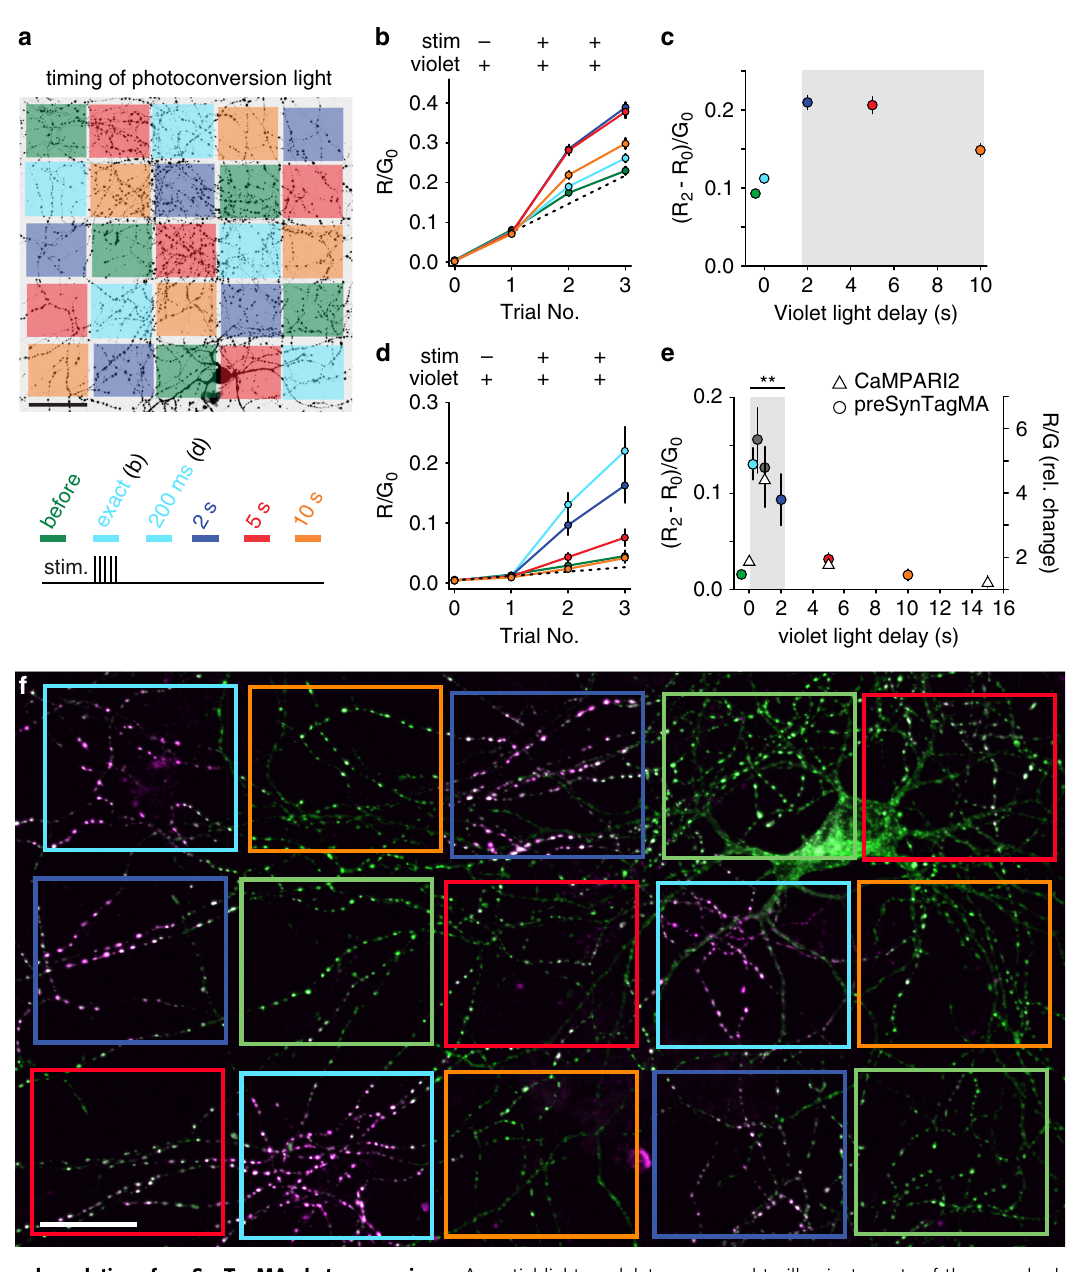
Fig. 2 Temporal resolution of preSynTagMA photoconversion. a A spatial light modulator was used to illuminate parts of the axonal arbor (405 nm, 50 mW cm − 2 , 100 ms) at different times relative to a brief tetanic stimulation (5 APs). After each trial, new images were acquired. ‘ Exact ’ & ‘ 200 ms ’ timing share the same color code (cyan) as we used ‘ exact ’ timing in sypCaMPARI experiments and a 200 ms delay in preSynTagMA experiments. b Ratio of red to green fl uorescence (R/G 0 ) from sypCaMPARI boutons illuminated at different times relative to the electrical stimulation. Trial 1 shows the effect of illumination without stimulation. Line color code as in a , n = 6 neurons. c Activity-dependent photoconversion ( Δ R/G 0 ) versus delay from start of stimulation to violet light from the same experiments in b . The gray box indicates the time window for ef fi cient photoconversion of sypCaMPARI. d Neurons expressing preSynTagMA (synaptophysin-CaMPARI2 (F391W_ L398V)) were stimulated as in a – c . Note the greatly reduced increase in R/G 0 with violet light alone (Trial 1). n = 6 neurons. e Left axis: activity-dependent photoconversion ( Δ R/ G 0 ) versus delay of preSynTagMA expressing neurons (circles). n = 12 neurons for the before, 200 ms, and 2 s conditions and n = 6 neurons for the 500 ms, 1 s, 5 s and 10 s conditions. Right axis: photoconversion of CaMPARI2(F391W_L398V) after 50 bAPs and 100 ms violet light (triangles). n = 5 neurons. f Cultured rat hippocampal neuron expressing preSynTagMA, trial # 3 from d . Boxes indicate regions where photoconversion light was applied with different delays (color code as in a ). All data are presented as mean ± SEM. In e , a Kruskal-Wallis test followed by the Benjamini-Hochberg FDR method was used. Timing conditions inside the gray box were not signi fi cantly different while the timing conditions outside the gray box were signi fi cantly different from those within the box ( p < 0.001). Scale bars: 50 µ m ( a ), 25 µ m ( f ). Cultured neurons were 14 – 18 days old, expressing sypCaMPARI or preSynTagMA for 8 – 16